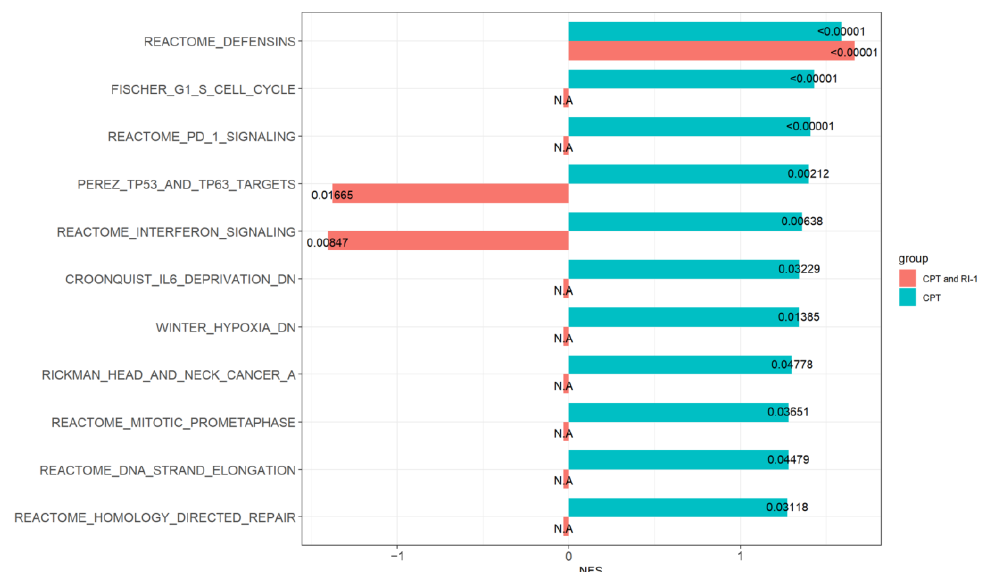
Figure 7. Impact of RAD51 inhibitor on camptothecin-induced changes in gene expression in cancer cells. Esophageal adenocarcinoma (FLO-1) cells were treated with RAD51 inhibitor (RI-1; 20 μM), camptothecin (CPT; 100 nM) or combination of both (RI-1 + CPT) for 24 h and impact on gene expression monitored by RNASeq. Green bars show pathways which were upregulated by CPT and red bars show the impact of RI-1 on their upregulation.